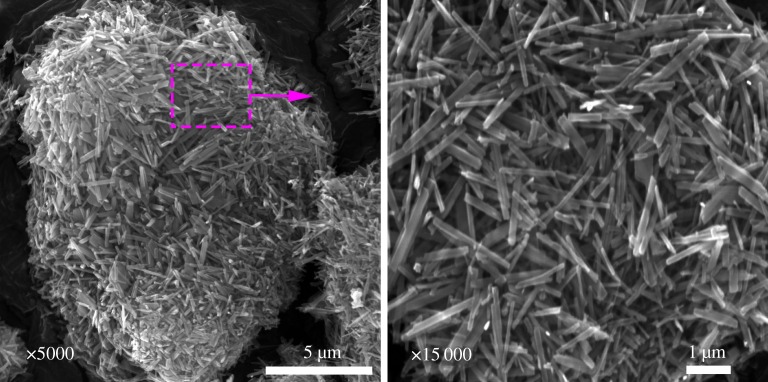
SEM images of as-synthesized VO2 (a ×5000, b ×15 000).